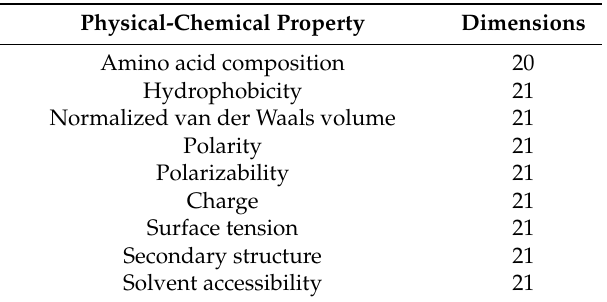
Table 6. Structure of 188-D